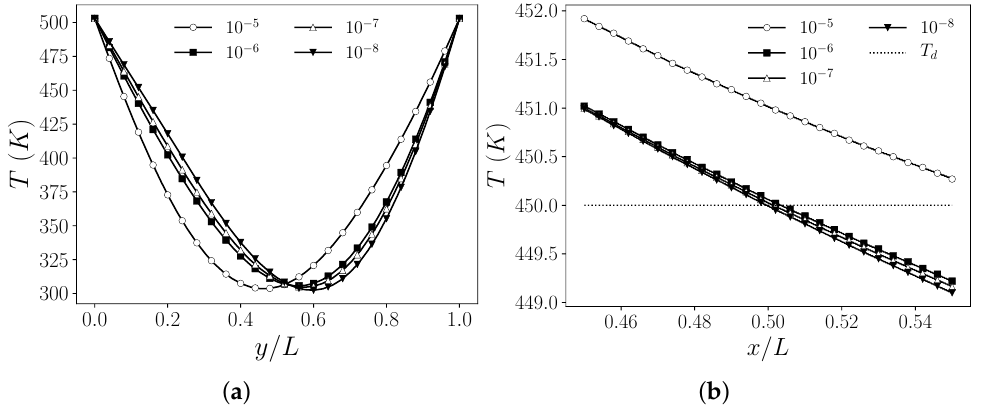
Figure 4. Temperature matching case with Dirichlet boundary control: temperature T profiles plotted against y / L along the controlled boundary Γ c ( a ); temperature T profiles plotted against x / L on the region Ω d along the line y / L = 0.8 ( b ). Numerical results for λ = 10 − 5 ,10 − 6 ,10 − 7 , and 10 − 8 . The target value T d is shown as a dotted